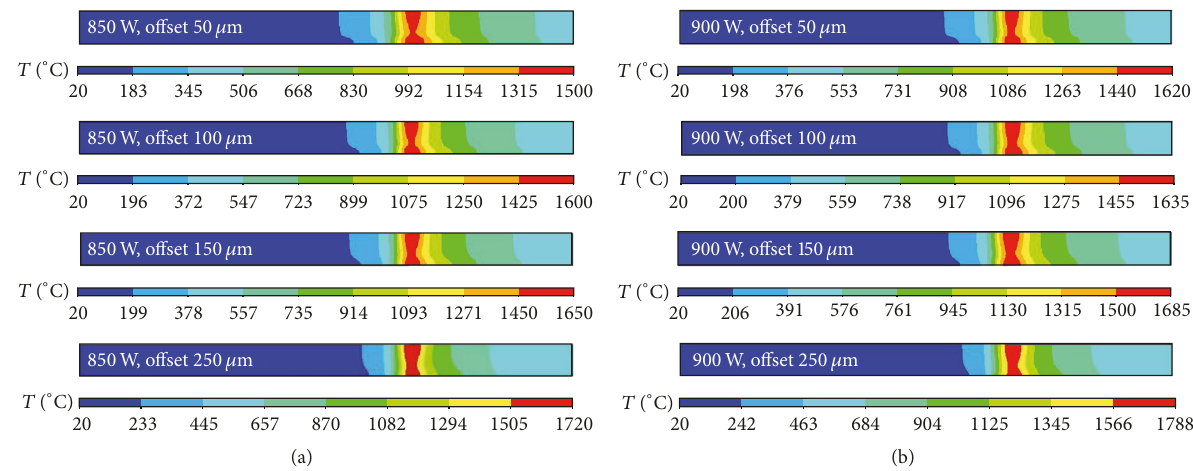
Figure 13: Temperature fields in the cross section along the plane of weld centre in the time of 1 second from the beginning of laser welding. (a) Laser power 850 W; (b) laser power 900 W.